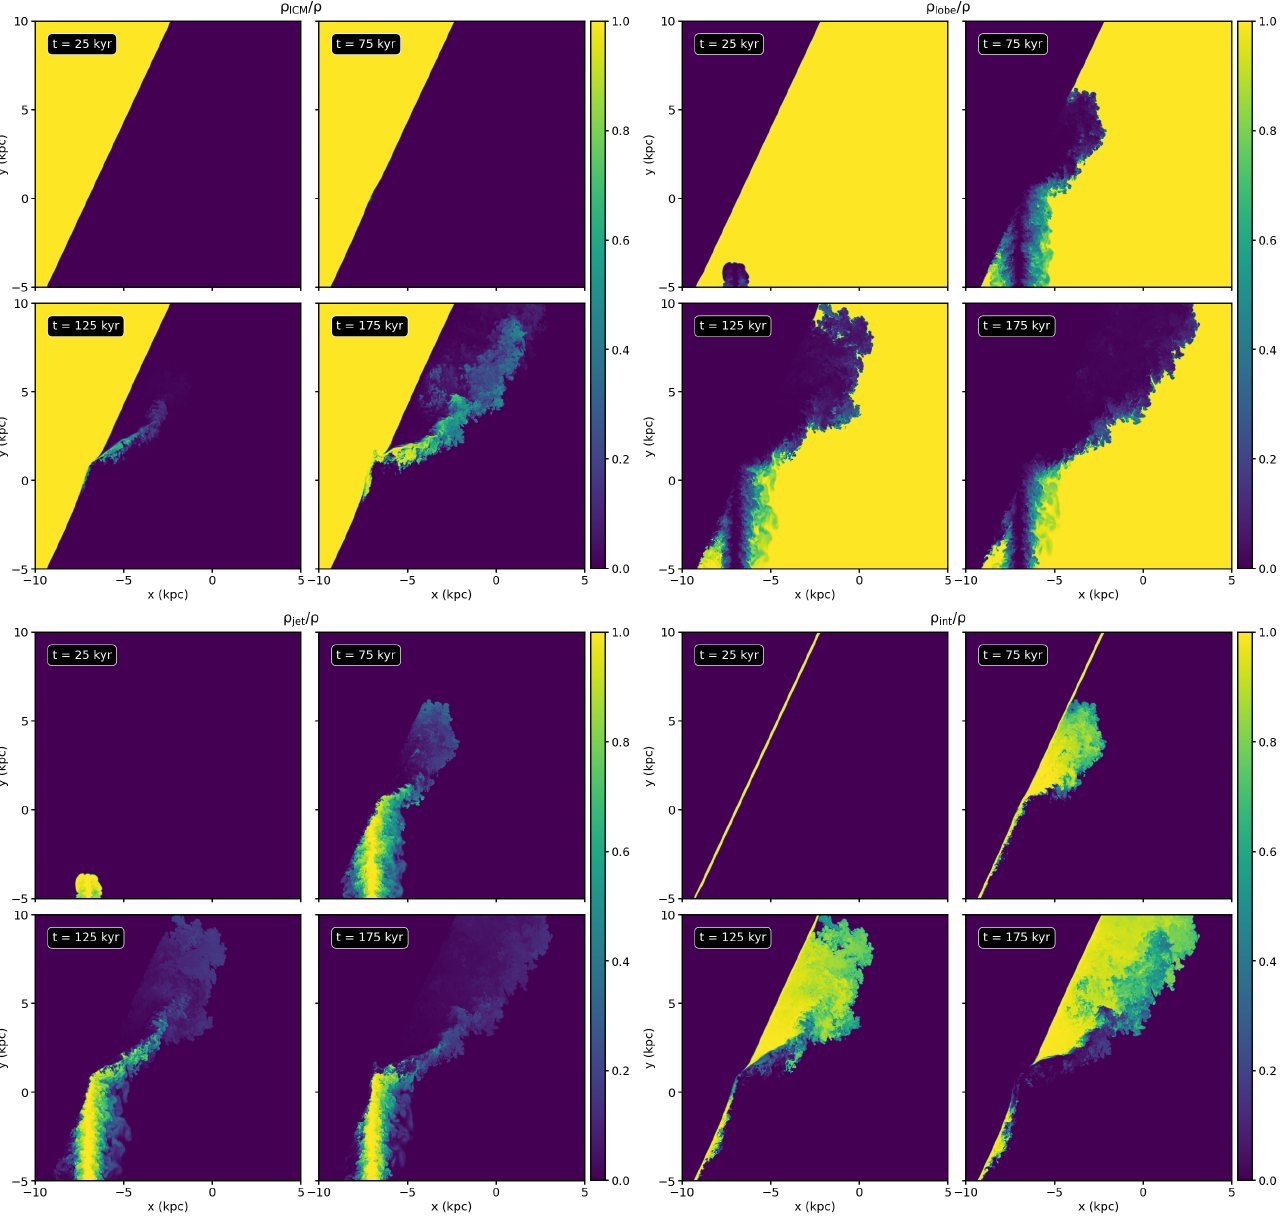
Figure 5. Slices through the center of the simulation domain of the four different passive scalar fields for the “fiducial” simulation at four different epochs: “ICM” ( top-left panels), “lobe” ( top-right panels), “jet” ( bottom-left panels), and “interface” ( bottom-right panels) Each panel is 15 kpc on a side, zoomed in slightly to focus on the parts of the simulation most affected by the